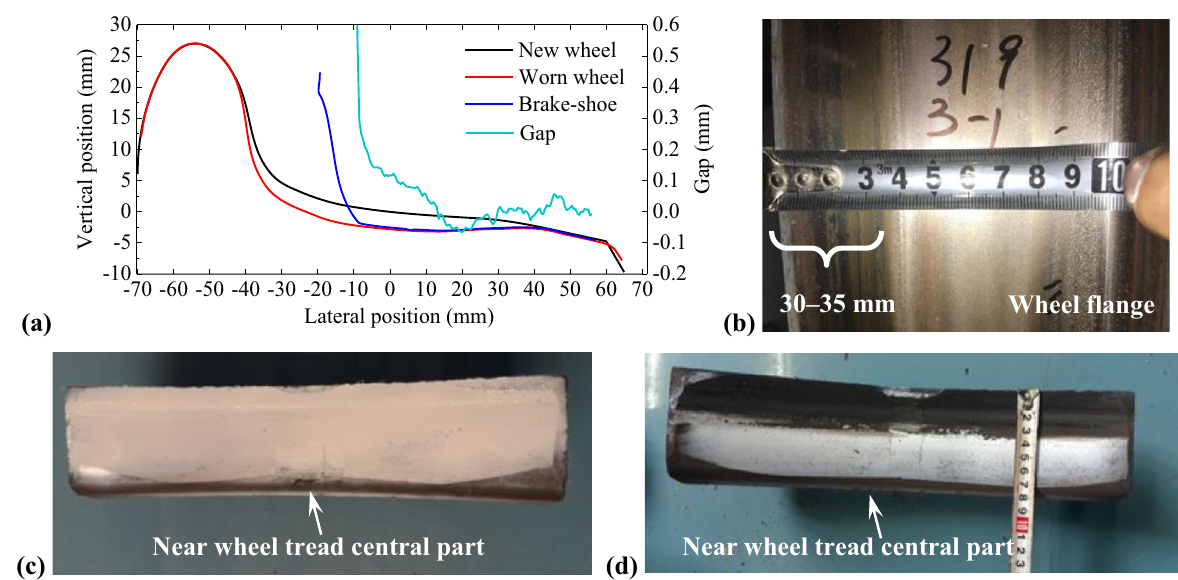
Fig. 22 a Matching relationship between brake shoe and wheel tread, b photograph of wheel tread, c photograph of brake shoe sprayed with white paint before test, and d photograph of brake shoe after test